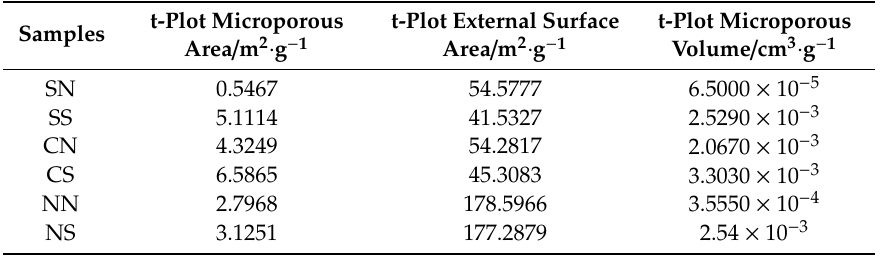
Table 3. t-Plot properties of titanium modified FeMgO x catalysts with di ff erent precursors.